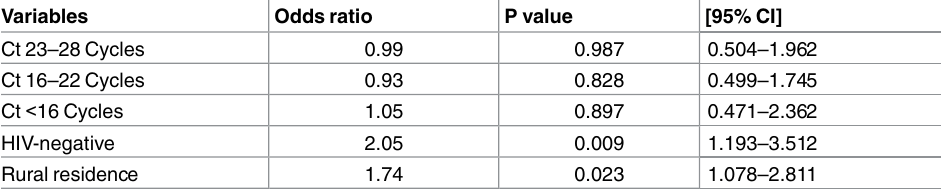
Table 2. Multivariate predictors of patientdelay for TB diagnosisin Manhiçadistrict,Maputo